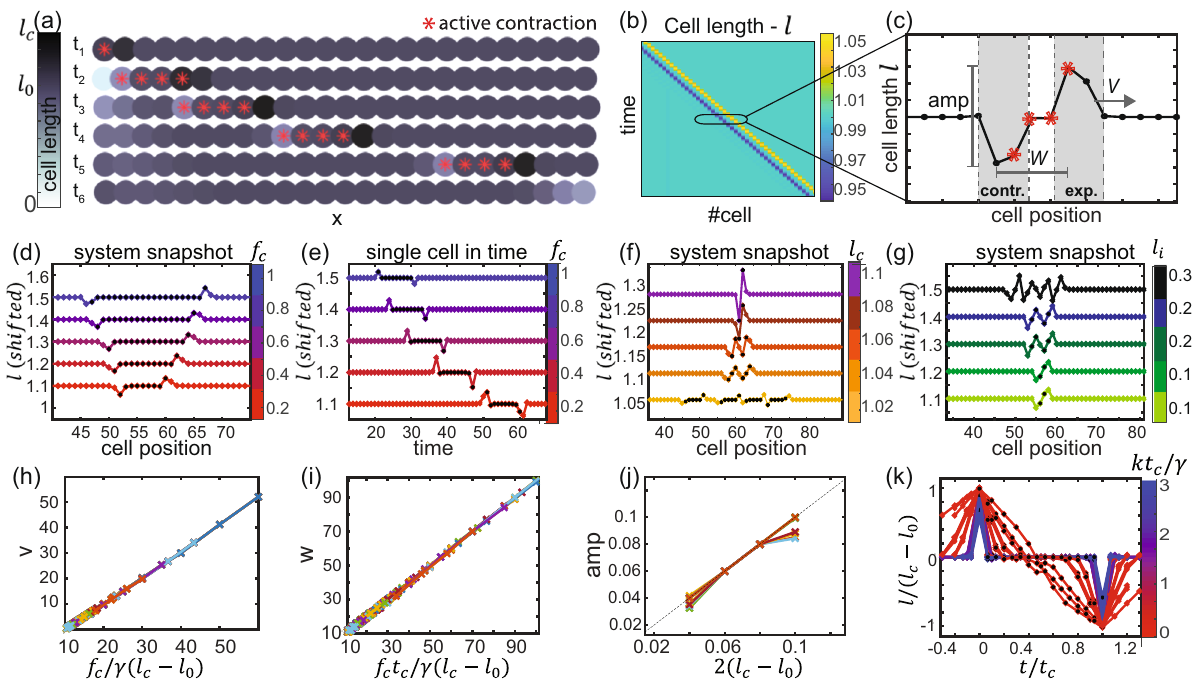
Fig. 2 Contraction pulses in a 1D excitable tissue. a Sequential snapshots from a dynamic simulation of a 1D chain of excitable cells (in which the rest length, l 0 , is shorter than the critical length l c ), show the propagation of a single contraction pulse from left to right (Supplementary Movie 1). Cells are shown as circles, at their location along the chain, x , with a color representing their length, l . At time t 0 all cells are set at their rest length, l 0 , except the fi rst cell on the left, which is initiated at l i > l c , which triggers the pulse. Red asters represent activly contracting cells. b A kymograph representation of the dynamics shows the pulse propagation in the tissue at constant pulse width, W , and speed, V (de fi ned in units of cells and cells per time, respectively). c A cross-section from the kymograph shows the pulse pro fi le: an expansion-front fi rst, and an equal but opposite contraction-front behind it. All cells in between are actively contracting yet found at their rest length. The main pulse characteristics ( V -velocity, W -width, amp -amplitude) are shown. d – g Pulse behavior with changing parameter values. Results are shifted by 0.1 in the y -axis in each experiment. Black dots represent activated cells. d – e System snapshots and time series show that increasing the contraction force, f c , increases the pulse ’ s width and speed respectively. f System snapshots show that increasing l c increases the amplitude amp . g System snapshots with different l i values show a series of identical pulses is emerging. The number of pulses depends on l i . h – j Numerical results of the main pulse characteristics show a collapse into our theoretical predictions, speci fi ed on the x axis. The ¼ 0 : 1 (cid:2) 1 ; ~ t (cid:4) t c k ¼ 0 : 1 (cid:2) 6 ; ~ ϵ (cid:4) l c (cid:2) l 0 ¼ 0 : 01 (cid:2) 0 : 05 ; where k is the cell stiffness, γ is the parameters used in the simulations are covering the range ~ f (cid:4) f c kl l 0 γ c media ’ s viscosity and t c is the duration of contraction. k Numerical results of the pulse pro fi le show the dependency of the shape on the speci fi ed